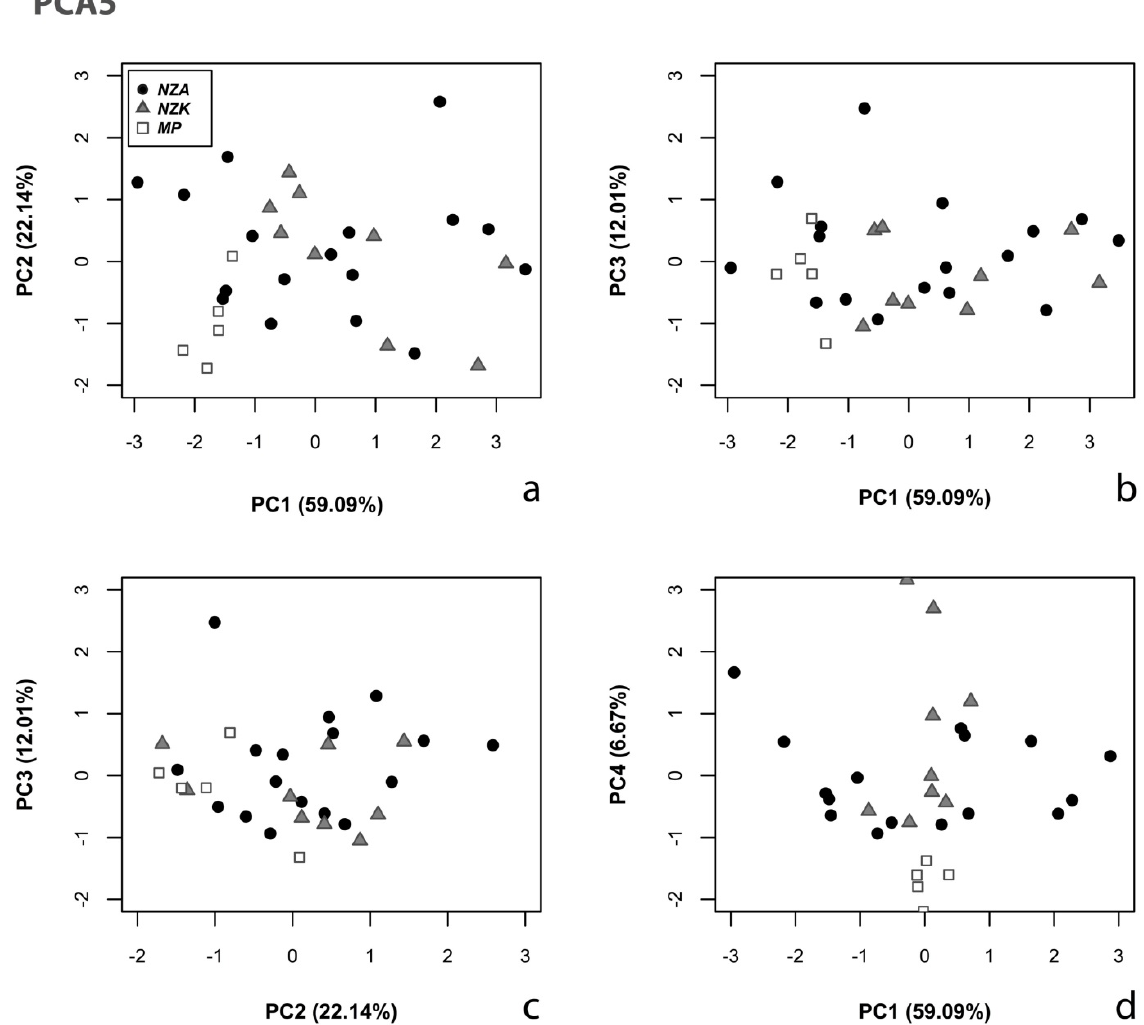
Figure 16. PCA5 - Plot of the PCA scores of the first four PCs. PCA is realised on the five indices listed in Table 1 and the results for this PCA are in Table 9 and concern only Lupemban points. Symbols represent sites (circles: NZA, triangles: NZK, squares: MP).